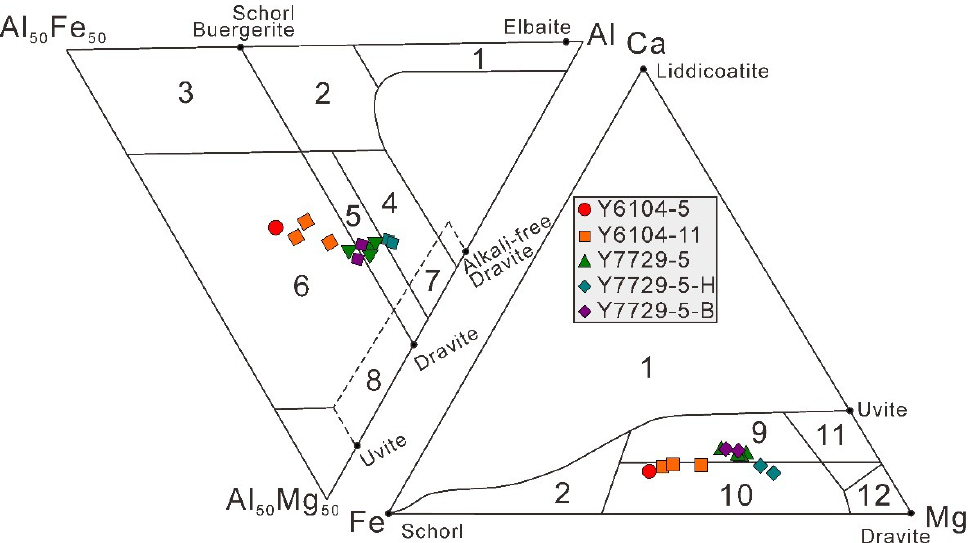
Figure 7. Compositional discrimination of tourmalines from the Yamansu deposit (modified after [30]). 1: Li-rich granitoids, pegmatites and aplites; 2: Li-poor granitoids and their associated pegmatites and aplites; 3: Fe 3+ -rich quartz-tourmaline rocks (hydrothermal altered granites); 4: Metapelites and metapsammites coexisting with Al-saturating phase; 5: Metapelites and metapsammites lacking Al-saturating phase; 6: Quartz-tourmaline rocks, calc-silicate rocks and metapelites; 7: Low-Ca meta-ultramafic rocks and metasediments; 8: Metacarbonates and metapyroxenites; 9: Ca-rich